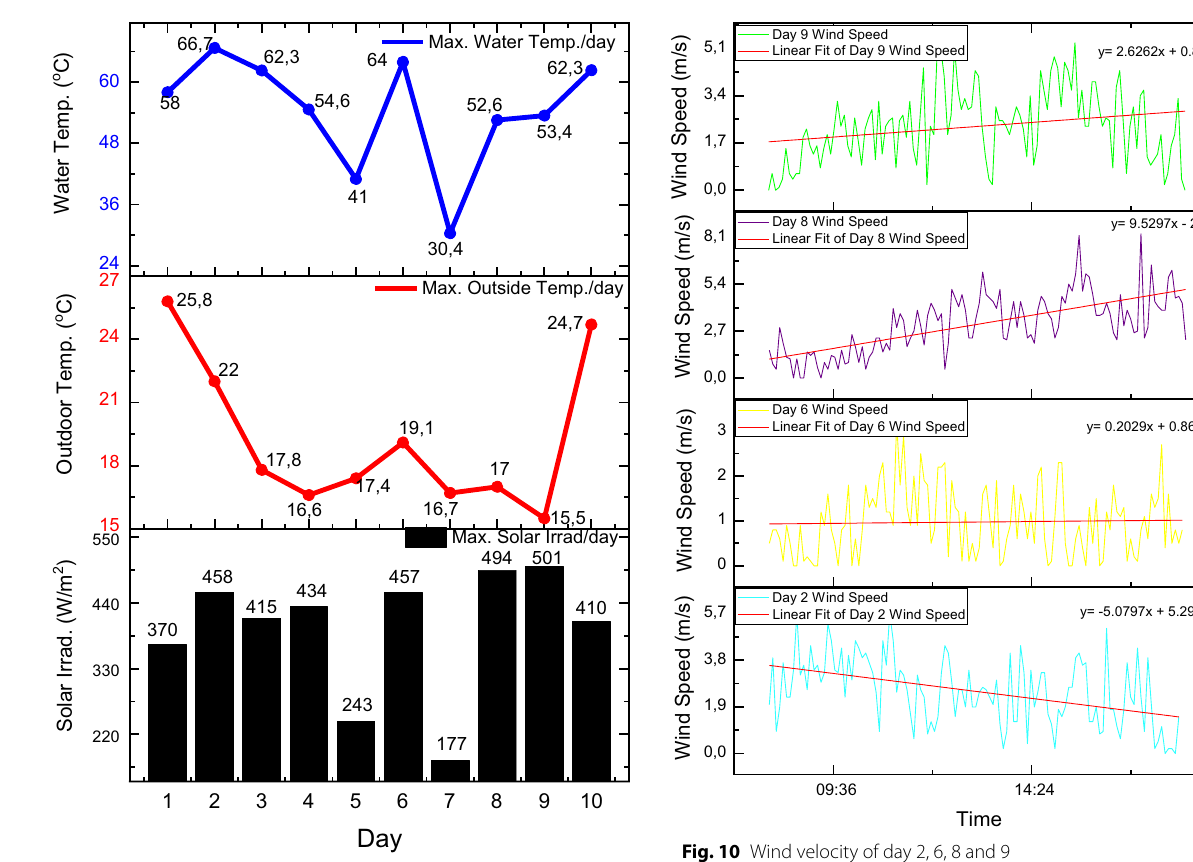
Fig. 9 Summarized results of solar irradiation, outdoor temperature and solar heated water temperature for the mid-winter days